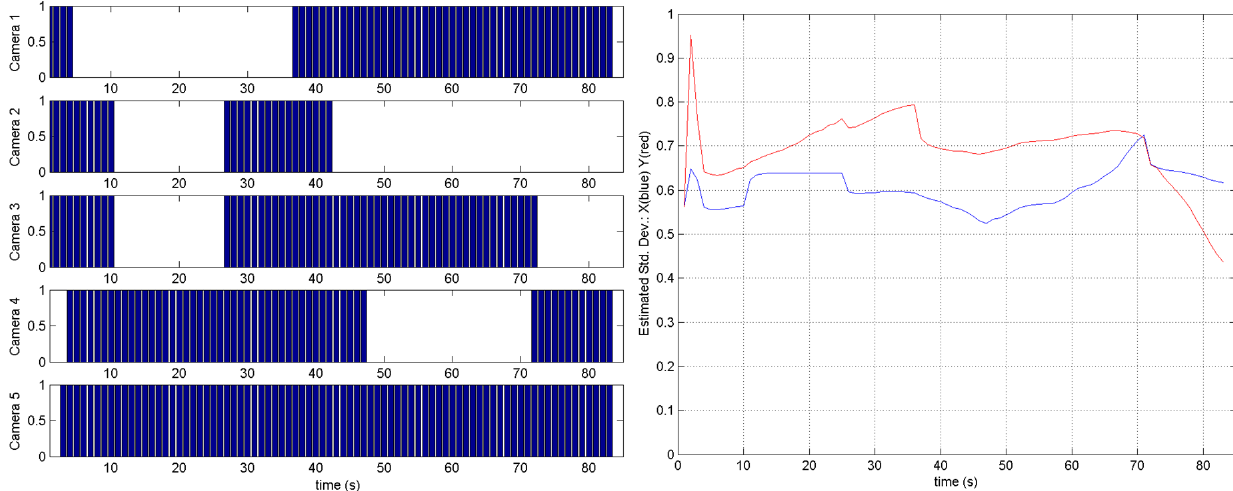
Figure 10. Results in an experiment of active object tracking with CMUcam3